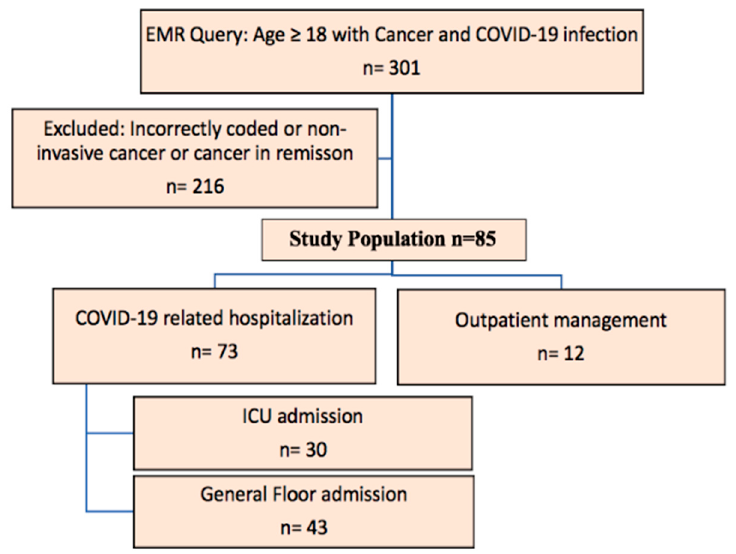
Figure 4. Study consort diagram.